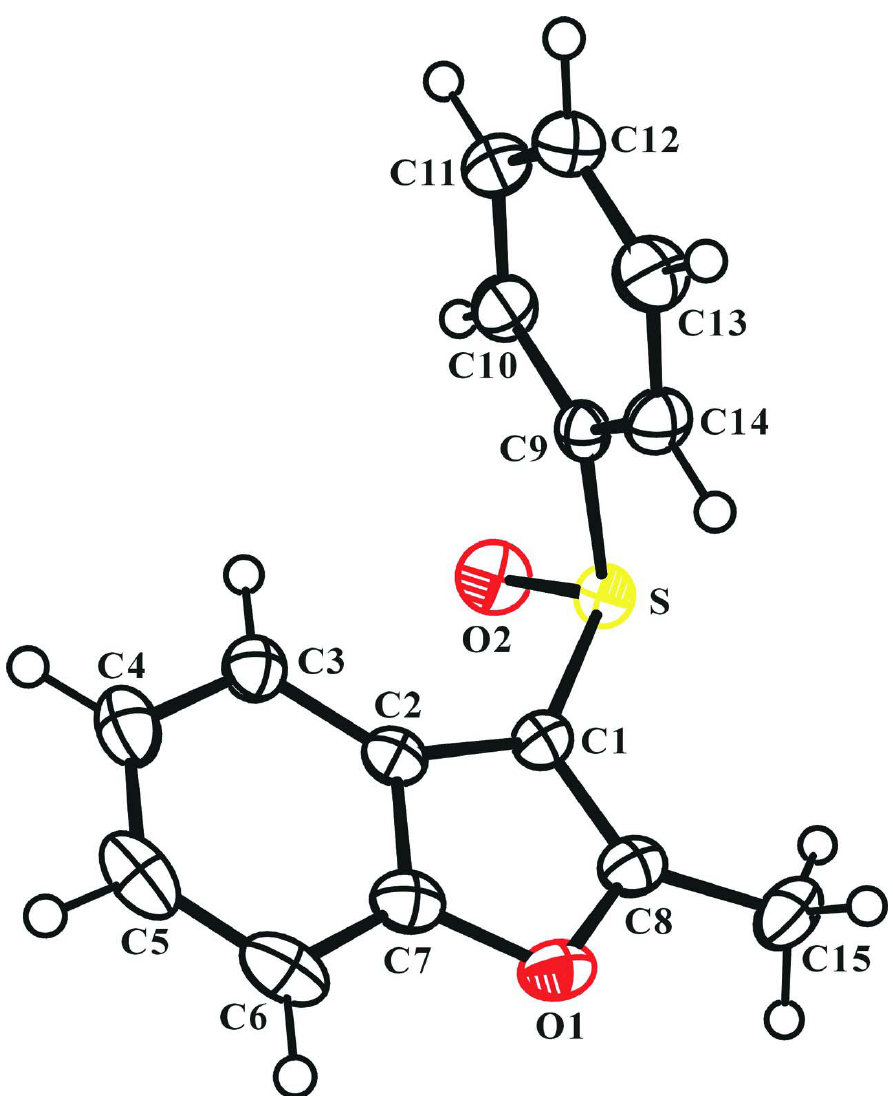
Figure 1 The molecular structure of the title compound, showing displacement ellipsoids drawn at the 50% probability